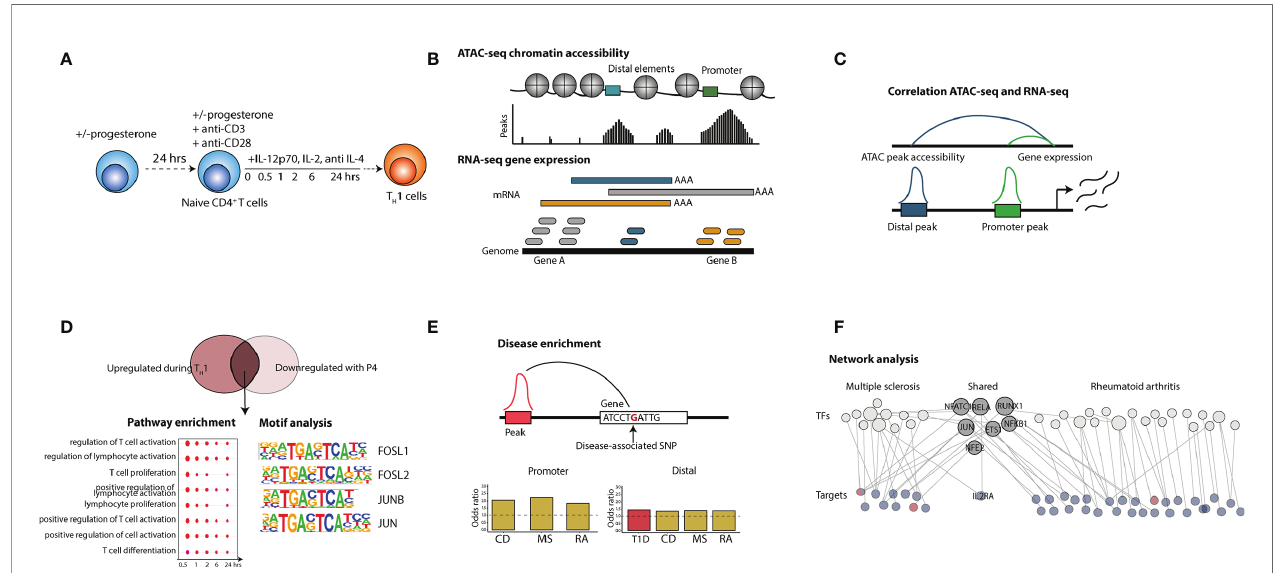
FIGURE 1 | Overview of the study. The fi gure shows the principal steps of the different analysis performed in the study. (A) Isolated naïve CD4 + T cells were activated with anti-CD3/28 beads in the presence of T H 1 polarizing factors (IL-12p70, IL-2 and anti-IL-4) for 0.5, 1,2, 6 and 24 hrs with or without P4 (n = 3). Naïve T cells cultured together with 50 µM P4 had also been pre-incubated with P4 for 24 hrs. (B) ATAC-sequencing to evaluate chromatin accessibility and RNA-seq for gene expression analysis were used as read out. (C) ATAC-seq and RNA-data was integrated through correlation where peak accessibility for promoter and distal peaks was correlated to changes in gene expression. (D) Peaks and genes upregulated during T H 1 differentiation were overlapped with peaks and genes downregulated by P4 and the intersecting changes were analyzed for pathway enrichment and transcription factor (TF) motif analysis. (E) The intersecting peaks were also associated to genes containing disease-SNPs for a wide array of different types of diseases and analyzed for disease enrichment. (F) Disease-associated changes connecting to changes induced by P4 were used to construct a network of disease-associated transcription factors and target genes for both MS and RA. CD, Crohn ’ s disease; MS, multiple sclerosis; SNP, single nucleotide polymorphism; TF, transcription factor; RA, rheumatoid